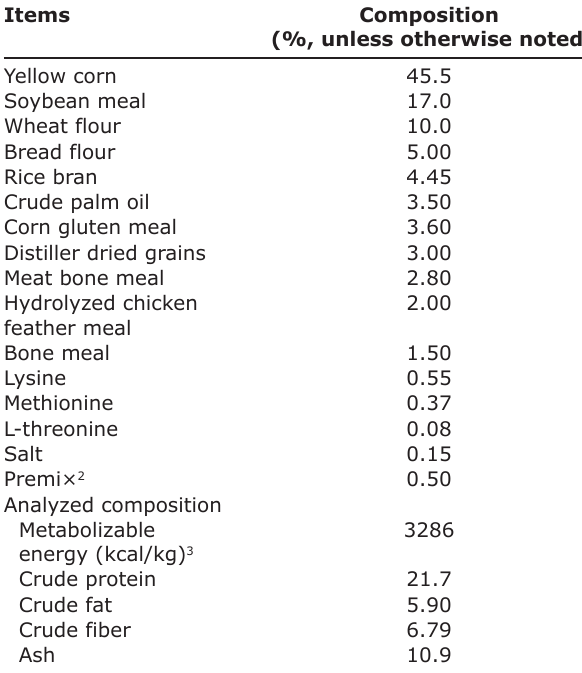
Table-1: Ingredients and chemical composition (as-dry basis) of basal diet provided to the Indonesian indigenous crossbred chickens 1